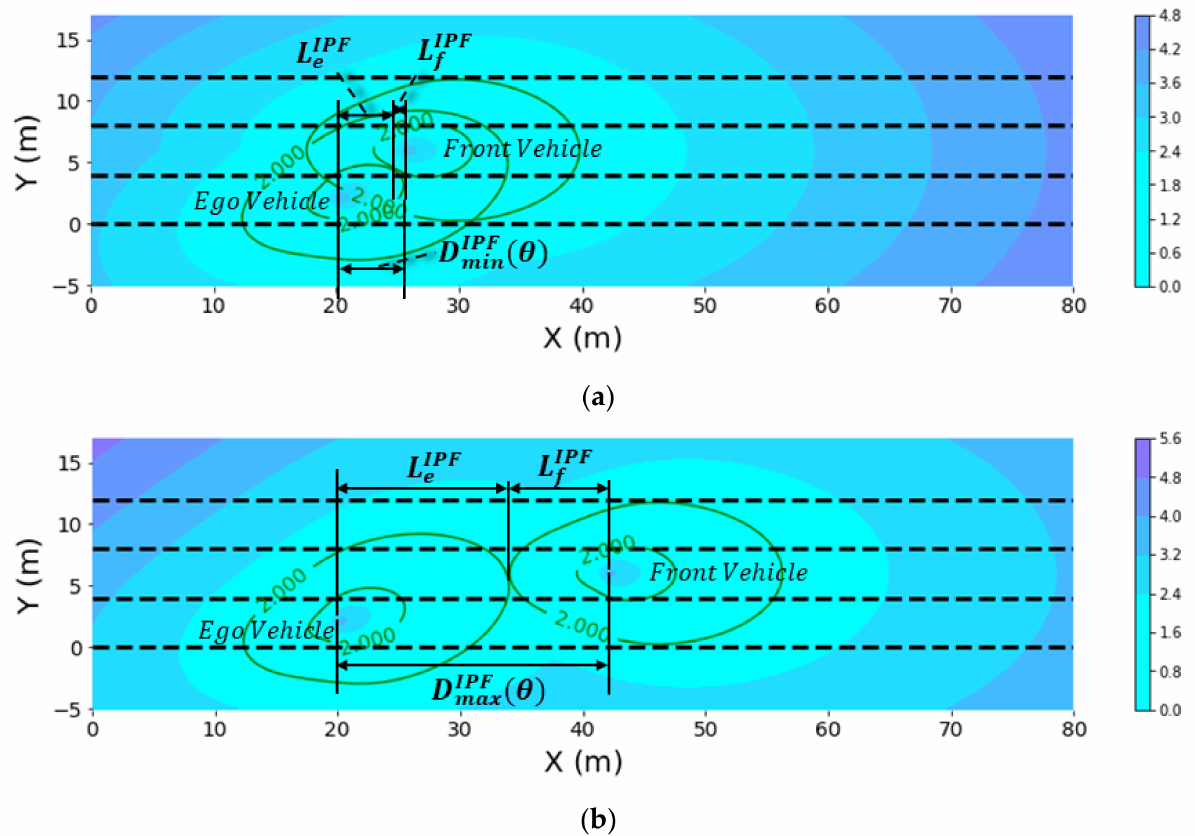
Figure 6. The critical situation for side collisions: ( a ) the inner circles of the fields are tangent to each other and ( b ) the outer circles of the fields are tangent to each